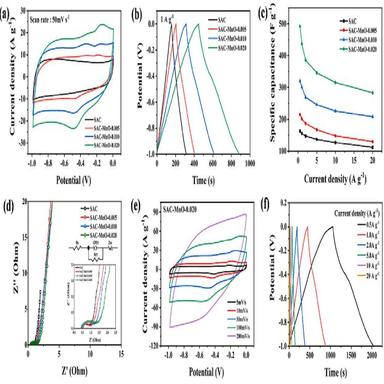
(a) CV curves of SAC and SAC-MnO-x (×0.005, 0.010 and0.020) electrodes at a scan rate of 50 mV s − 1 ; (b) GCD curves of SAC and SAC-MnO-x (×0.005, 0.010 and0.020) electrodes at a current density of 1 A g− 1 ; (c) Rate capability of SAC and SAC-MnO-x (×0.005, 0.010 and0.020). (d) EIS curves of SAC and SAC-MnO-x (×0.005, 0.010 and0.020); (e) CV curves of SAC-MnO-0.020 at different scan rates; (f) GCD curves of SAC-MnO-0.020 at different current densities.